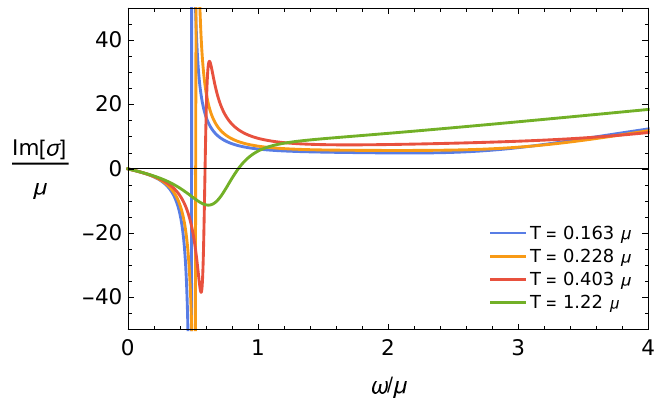
Figure 15. Imaginary part of the optical conductivity for the Reissner-Nordstr(cid:127)om metal in d = 3+1 with a double-trace deformation ( (cid:11) 2 = 1 = 10). We see that Im[ (cid:27) ( ! )] ! 0 for ! ! 0. This